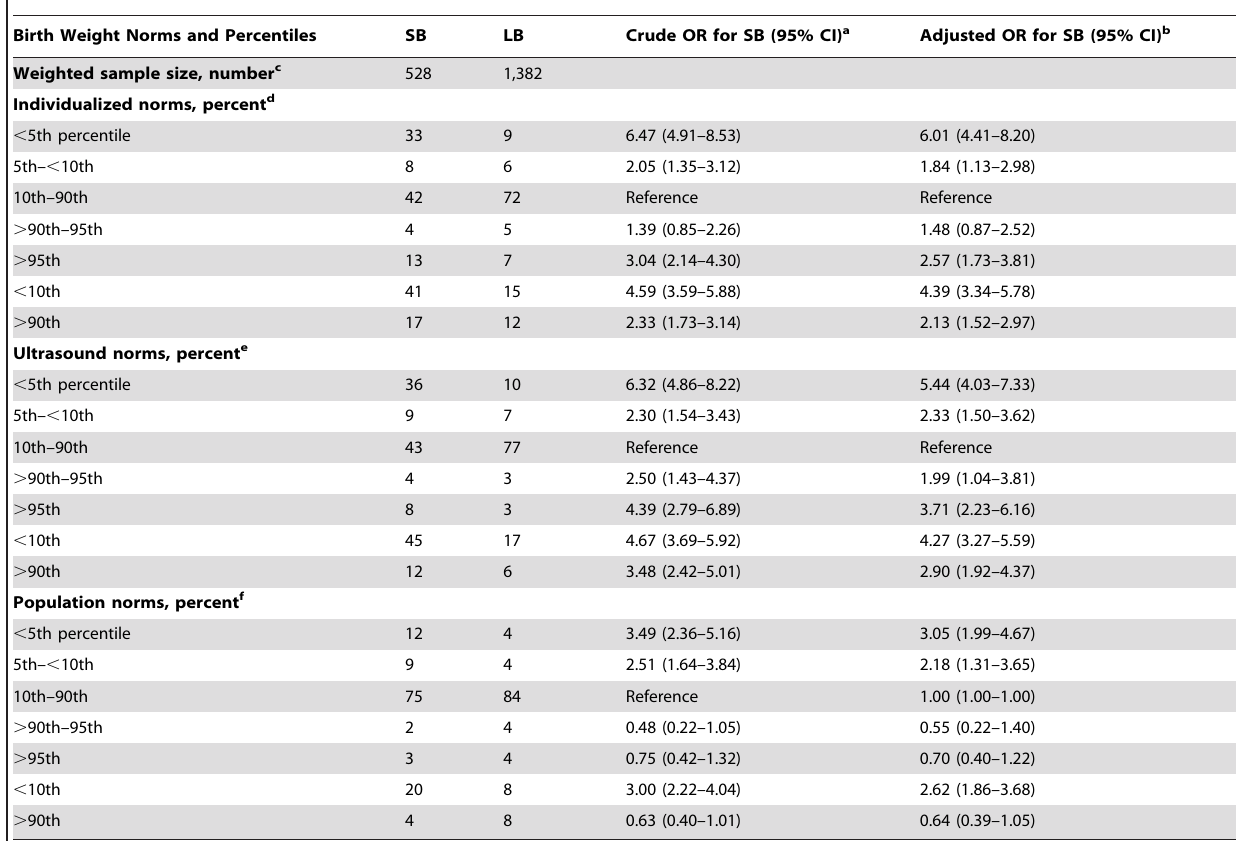
Table 4. Birth weight percentiles among stillbirths and live births.